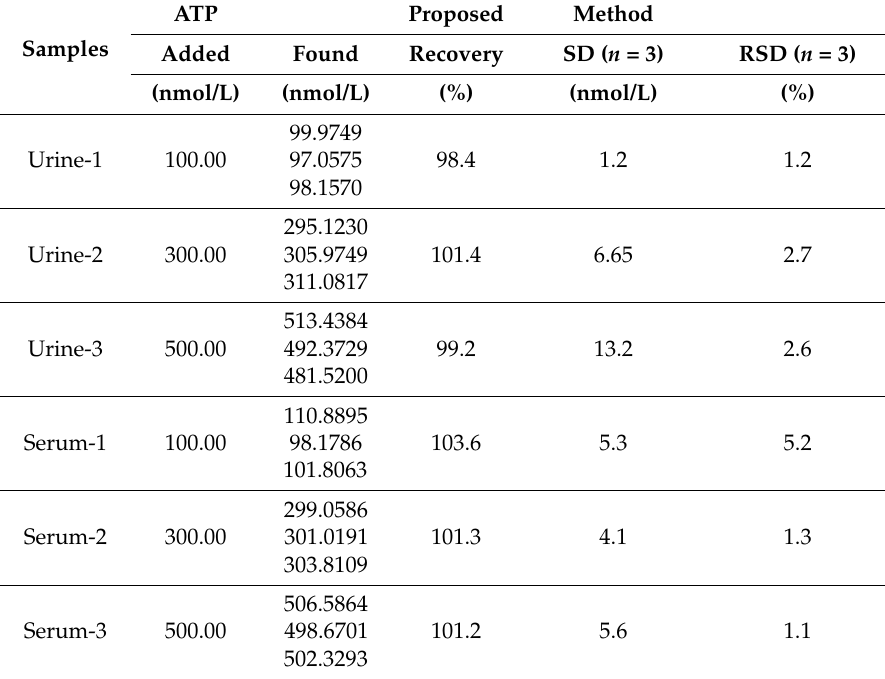
Table 2. Detection of ATP concentration in the real samples of urine and serum.